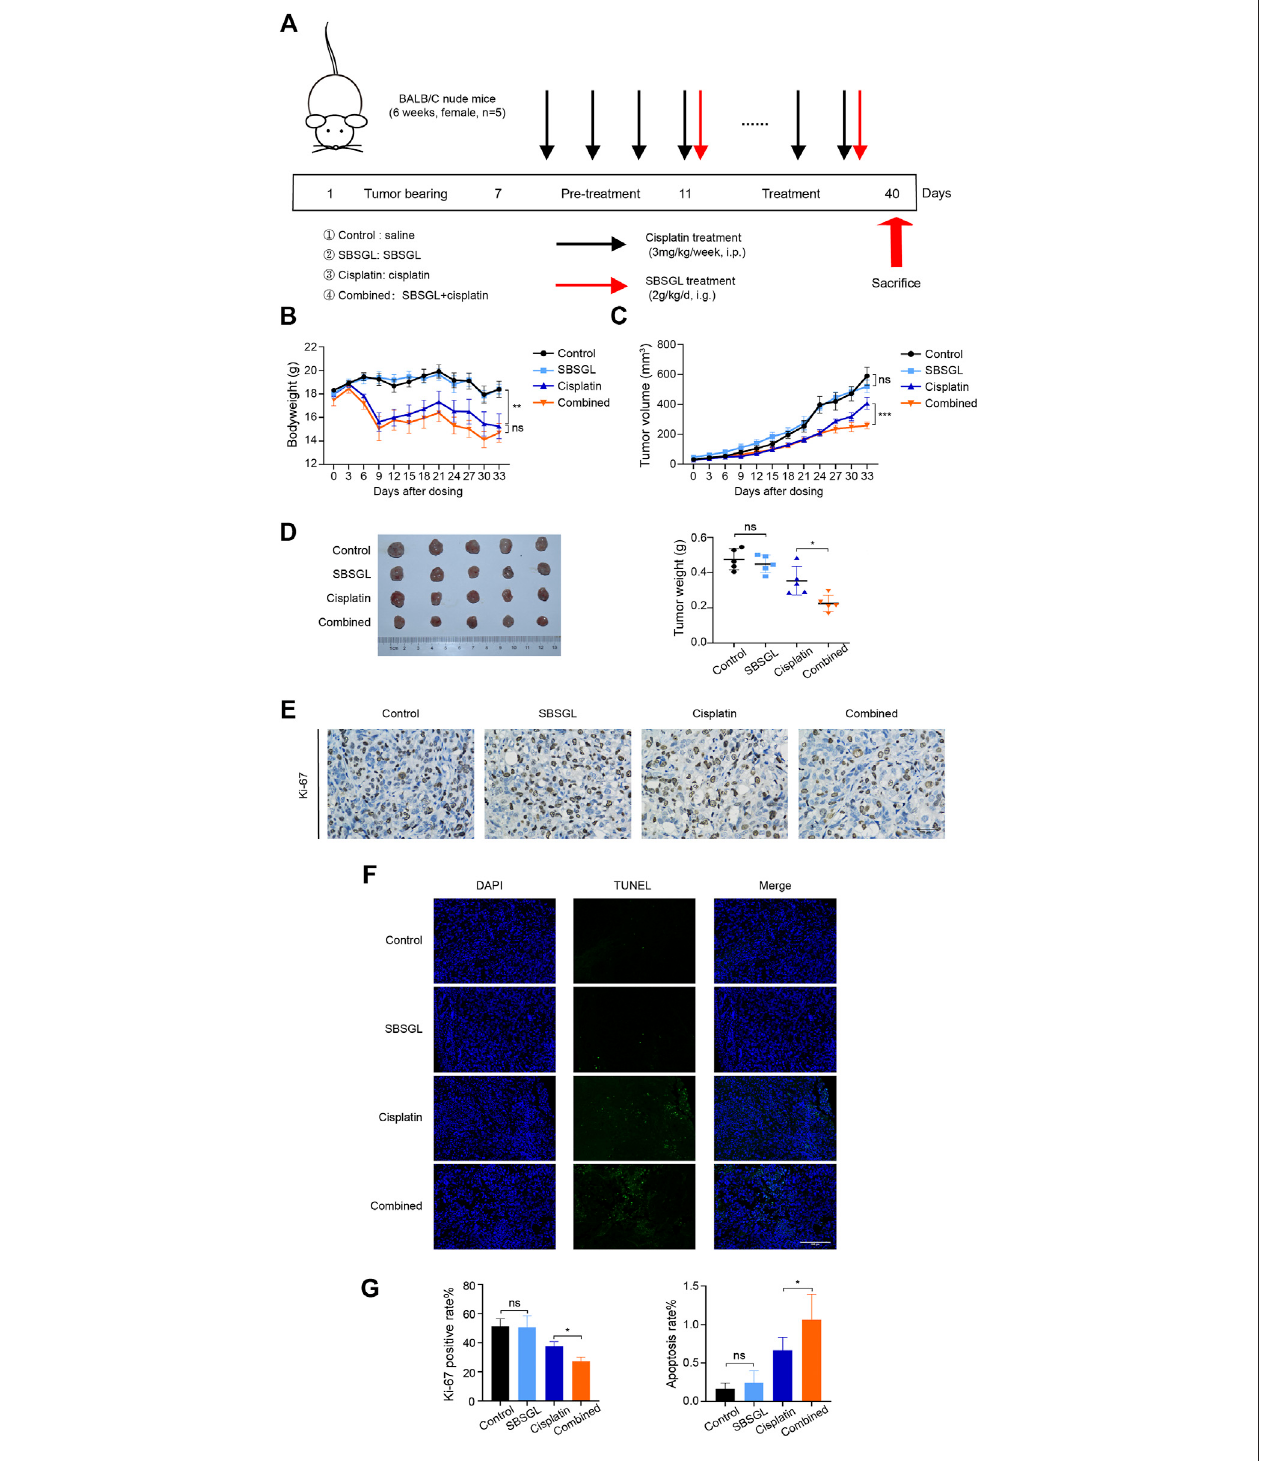
FIGURE1 | Sporoderm-broken sporesof Ganoderma lucidum (SBSGL) sensitized ovarian tumor tocisplatin in vivo . (A) The scheme ofthe animalexperiment. (B) The changes of bodyweight of nude mice. (C) The changes of tumor volume. (D) The picture of tumor masses and quantitative analysis of tumor weight. (E) The expressionofKi-67intumortissues. (F) TUNEL-positivenucleus(green)indicatedcellapoptosis.CellnucleiweredetectedbyDAPI(blue). (G) Thequantitativeanalysisof positive rate of Ki-67 and TUNEL. Data are presented as the mean ± SD or SEM ( n = 5). Compared to the control group or the cisplatin group: *** p < 0.001, ** p < 0.01, * p < 0.05, ns, no statistical signi fi cance.